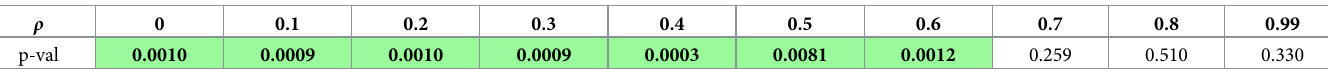
Table 1. Statistical significance of medication state effect on BDDLS. Showing p-values for the test that BDDLS is greater OFF than ON medication (sign rank test, all patients, both hemispheres, n = 16 per condition) as a function of the GWR surrogate parameter ρ . P-values in bold are smaller than 5%, while green indicates significance under FDR